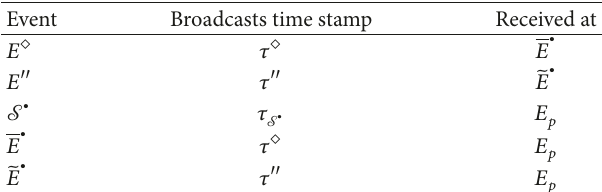
Figure 4: The causal structure of E ch with the event 𝑒 . Table 4: The events and their broadcast time stamps in the E ch system.